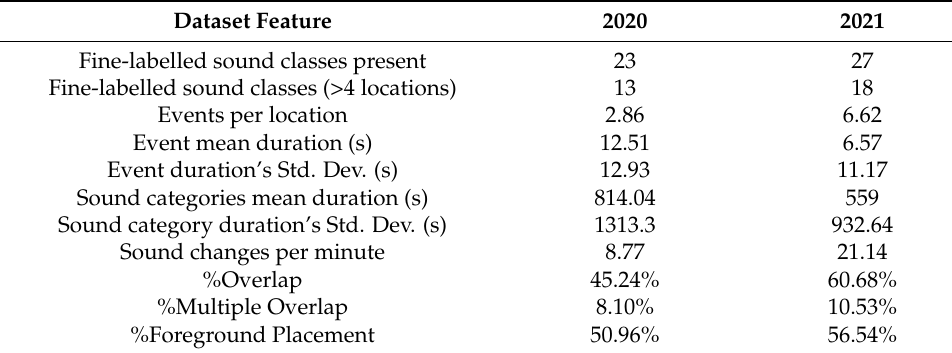
Table 3. 2020 and 2021 campaign dataset’s